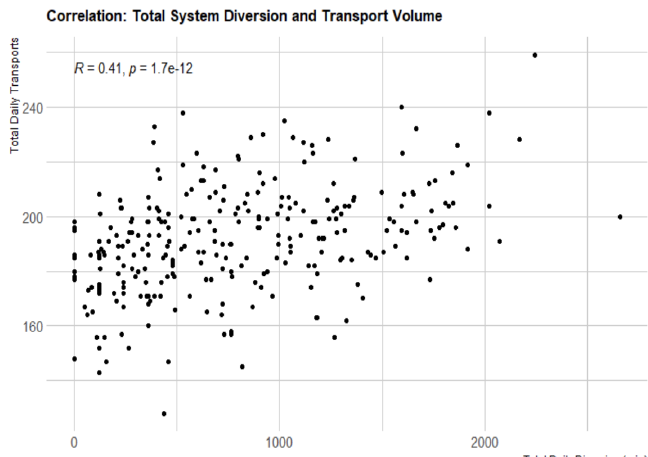
Figure 4. Daily system diversion totals from implementation of the study to January 2021. Total daily diversion on X-axis compared to total daily transports on y-axis. Total diversion time does not seem to correlate with daily